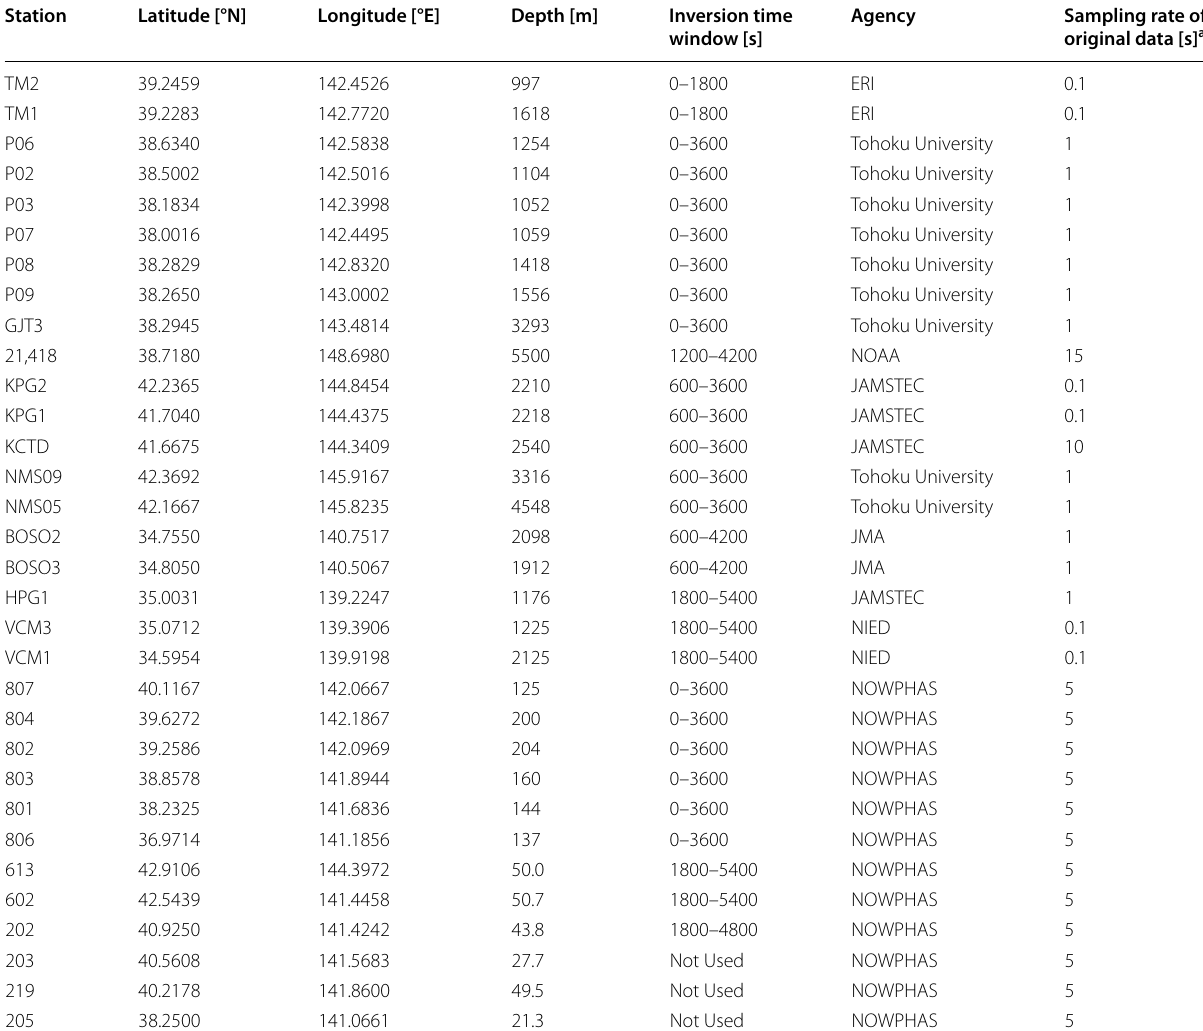
Table 1 List of tsunami stations used in this study